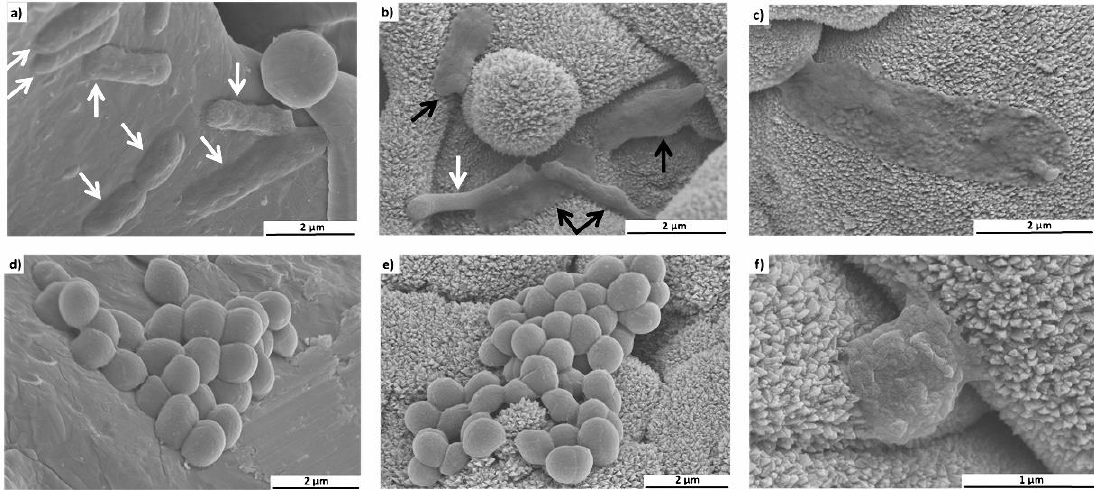
Figure 6. Representative SEM images of E. coli ( a – c ) and S. aureus ( d – f ) adherent to TPS ( a , d ) and nanostructured TPS+ ( b , c , e , f ) samples. The white arrow indicates morphologically intact E. coli ; black arrows, damaged E. coli .